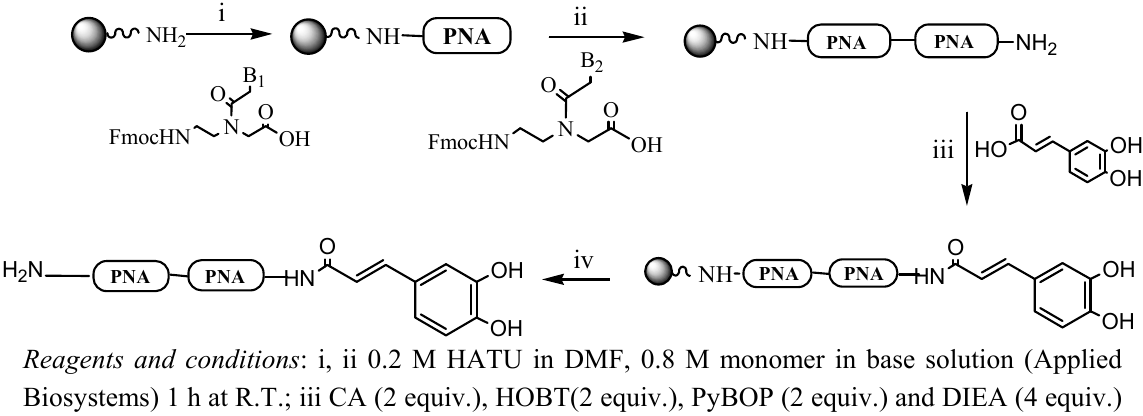
Scheme 1. Solid-phase synthesis of CA-PNA dimers. B = adenine and B = guanine in 2; B B 1 2 B = guanine in 4; B = guanine and B 2 1 B and B = guanine in 7. 1 2